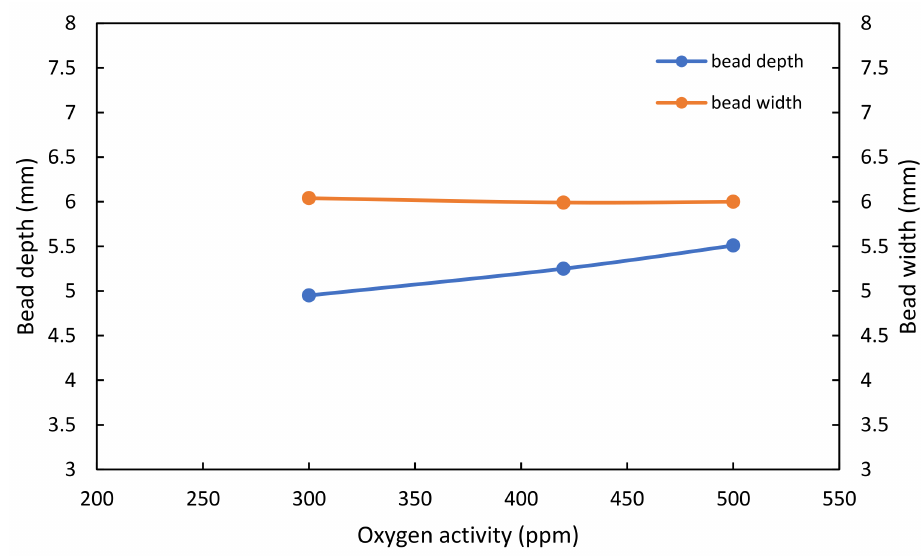
Figure 12. Change in weld depth and width with respect to oxygen concentration.